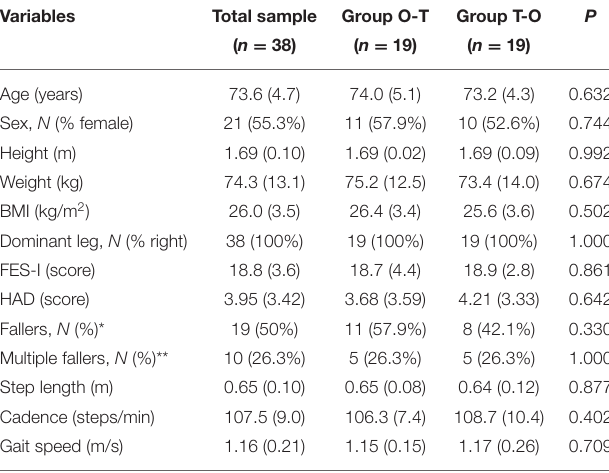
TABLE 2 | Participant characteristics, fall history, and usual gait